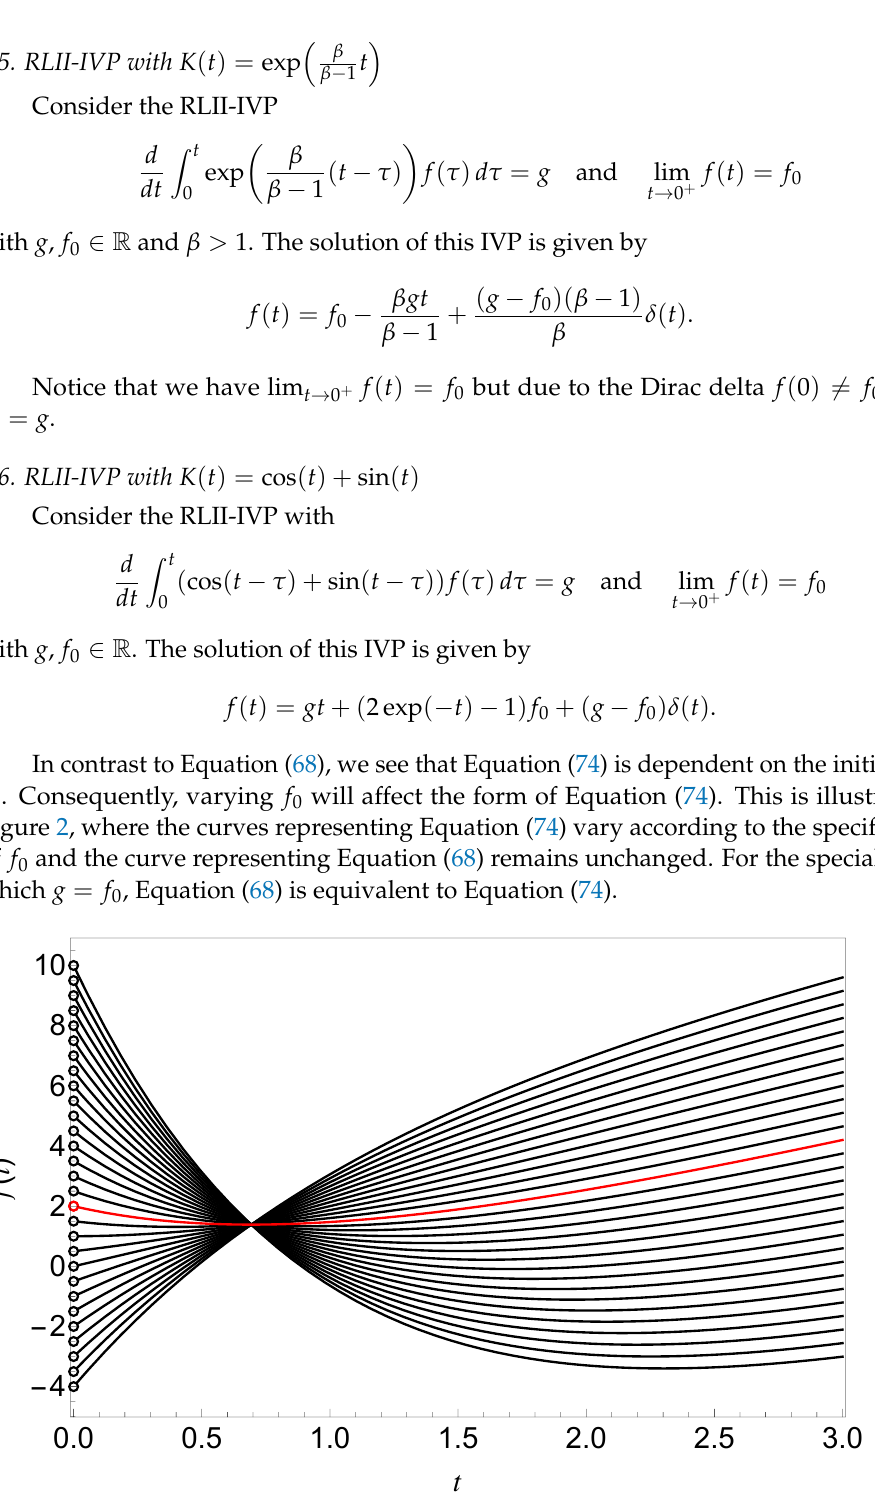
Figure 2. The black and red curves represent the IVP solutions given by Equations (68) and (74) respectively for varying values of f 0 with g = 2. The open circle on each curve indicates that both solutions are valid for t >